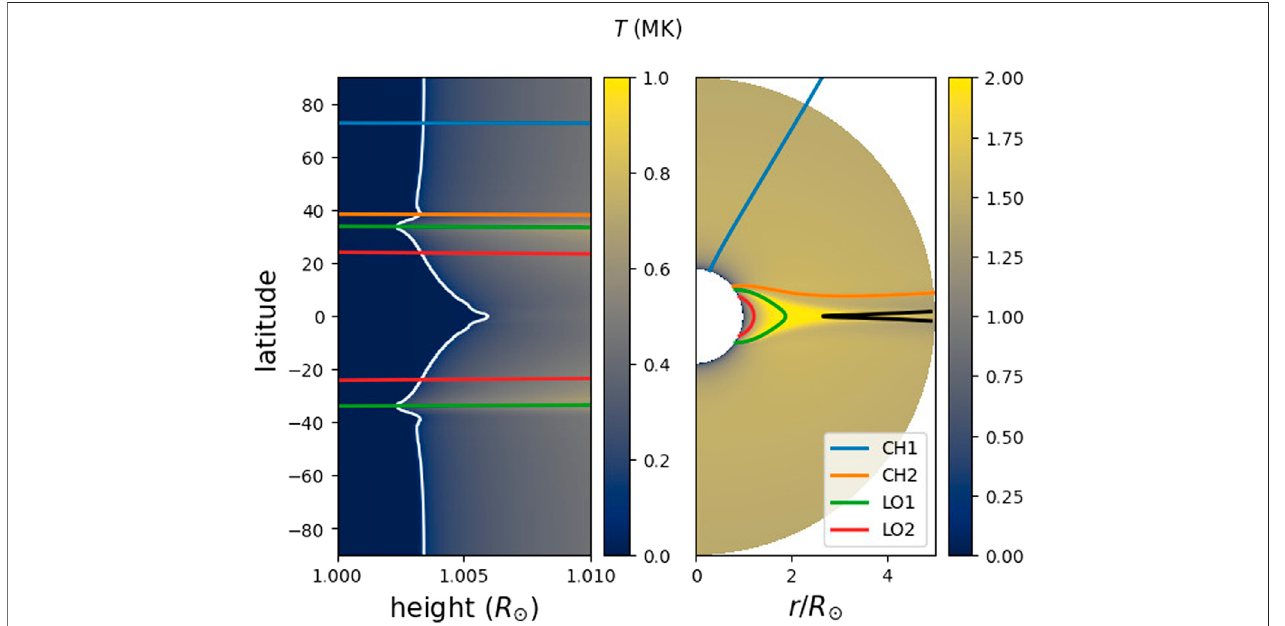
FIGURE 1 | Plasma temperature obtained with the global MHD model. On the left panel, we show the temperature pro fi le as a function of latitude and height. The white line shows the contour T (cid:1) 10 5 K, characterizing the location of the transition region. Blue lines and orange lines are open fi eld lines (referred as CH for coronal holes), green and red lines are coronal loops (referred as LO). They are almost perfectly radial at this scale. On the right panel, we show an extended view of the solution and integrated fi eld lines in the meridional plane up to 5 R ⊙ . The black line on the right is the Alfvén